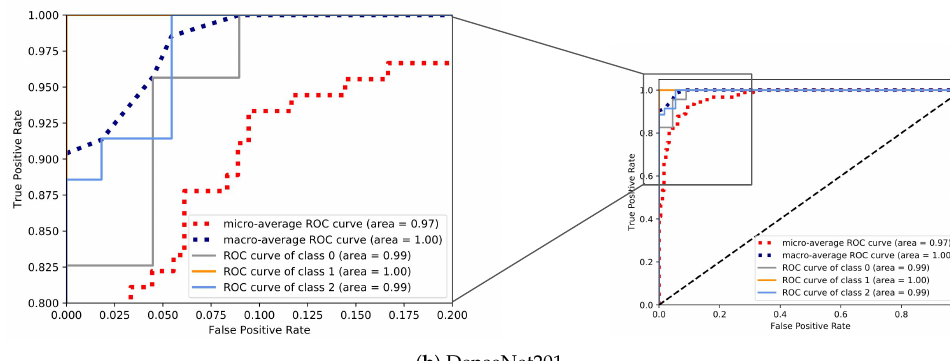
Figure 12. ROC curve of deep learning models for Pattern A.